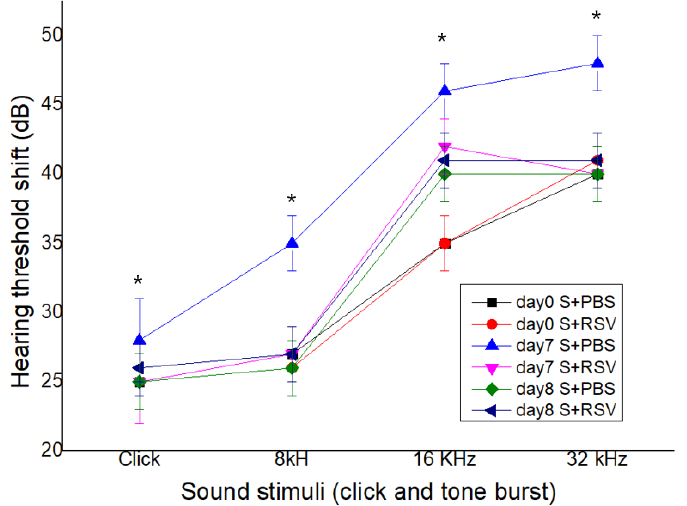
Figure 6. Resveratrol (RSV) attenuated a salicylate-induced elevation of auditory brainstem response (ABR) threshold in rats. RSV attenuated a salicylate-induced elevated ABR threshold shift except in the click group; salicylate injection given for seven consecutive days. * p < 0.05.